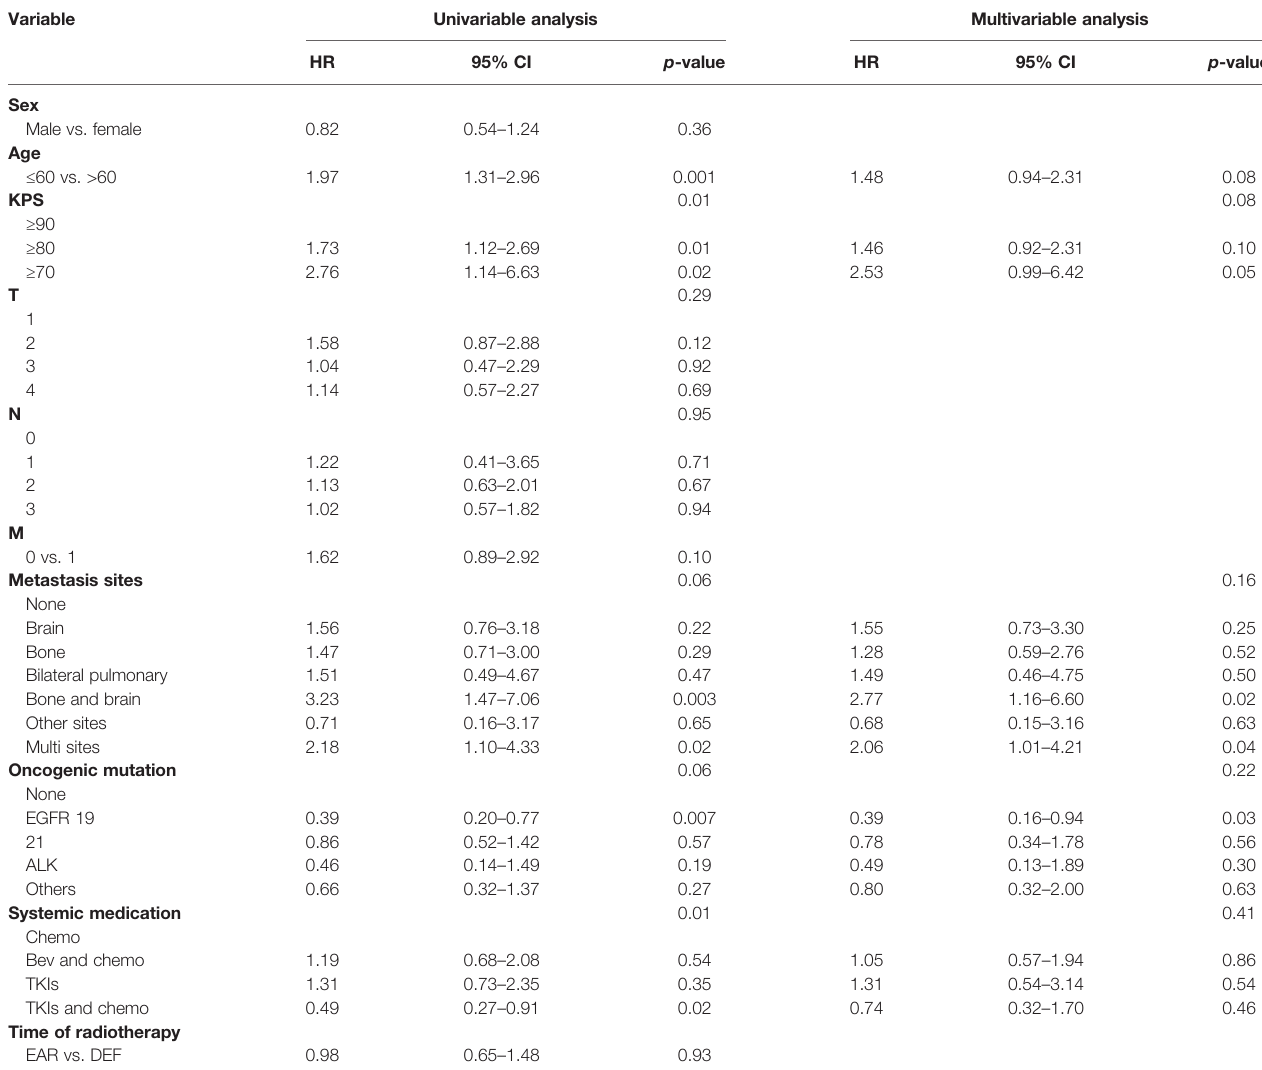
TABLE 3 | Univariable and multivariable analyses of covariables associated with OS.